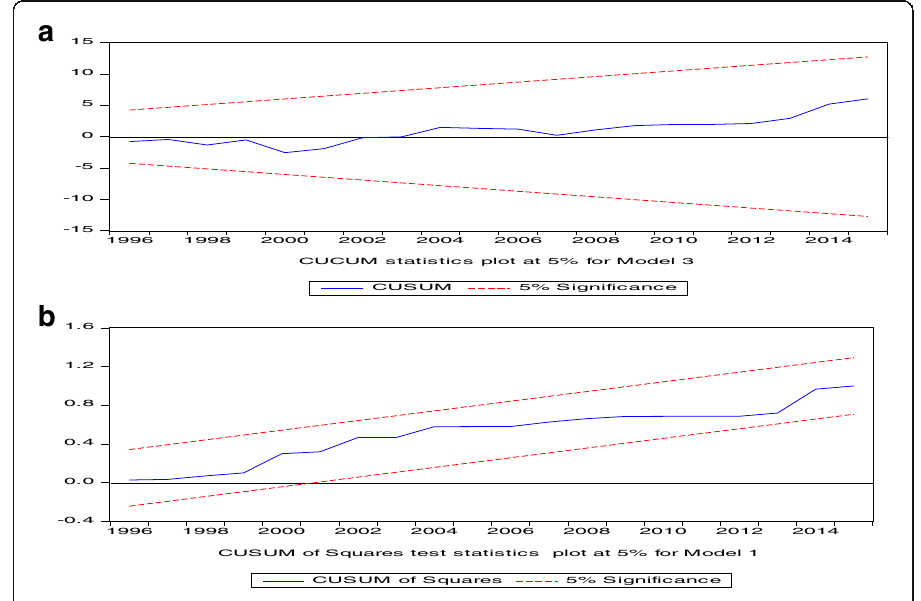
Fig. 4 a CUCUM statistics plot at 5% for Model 3. b : CUSUM of Squares test statistics plot at 5% for Model